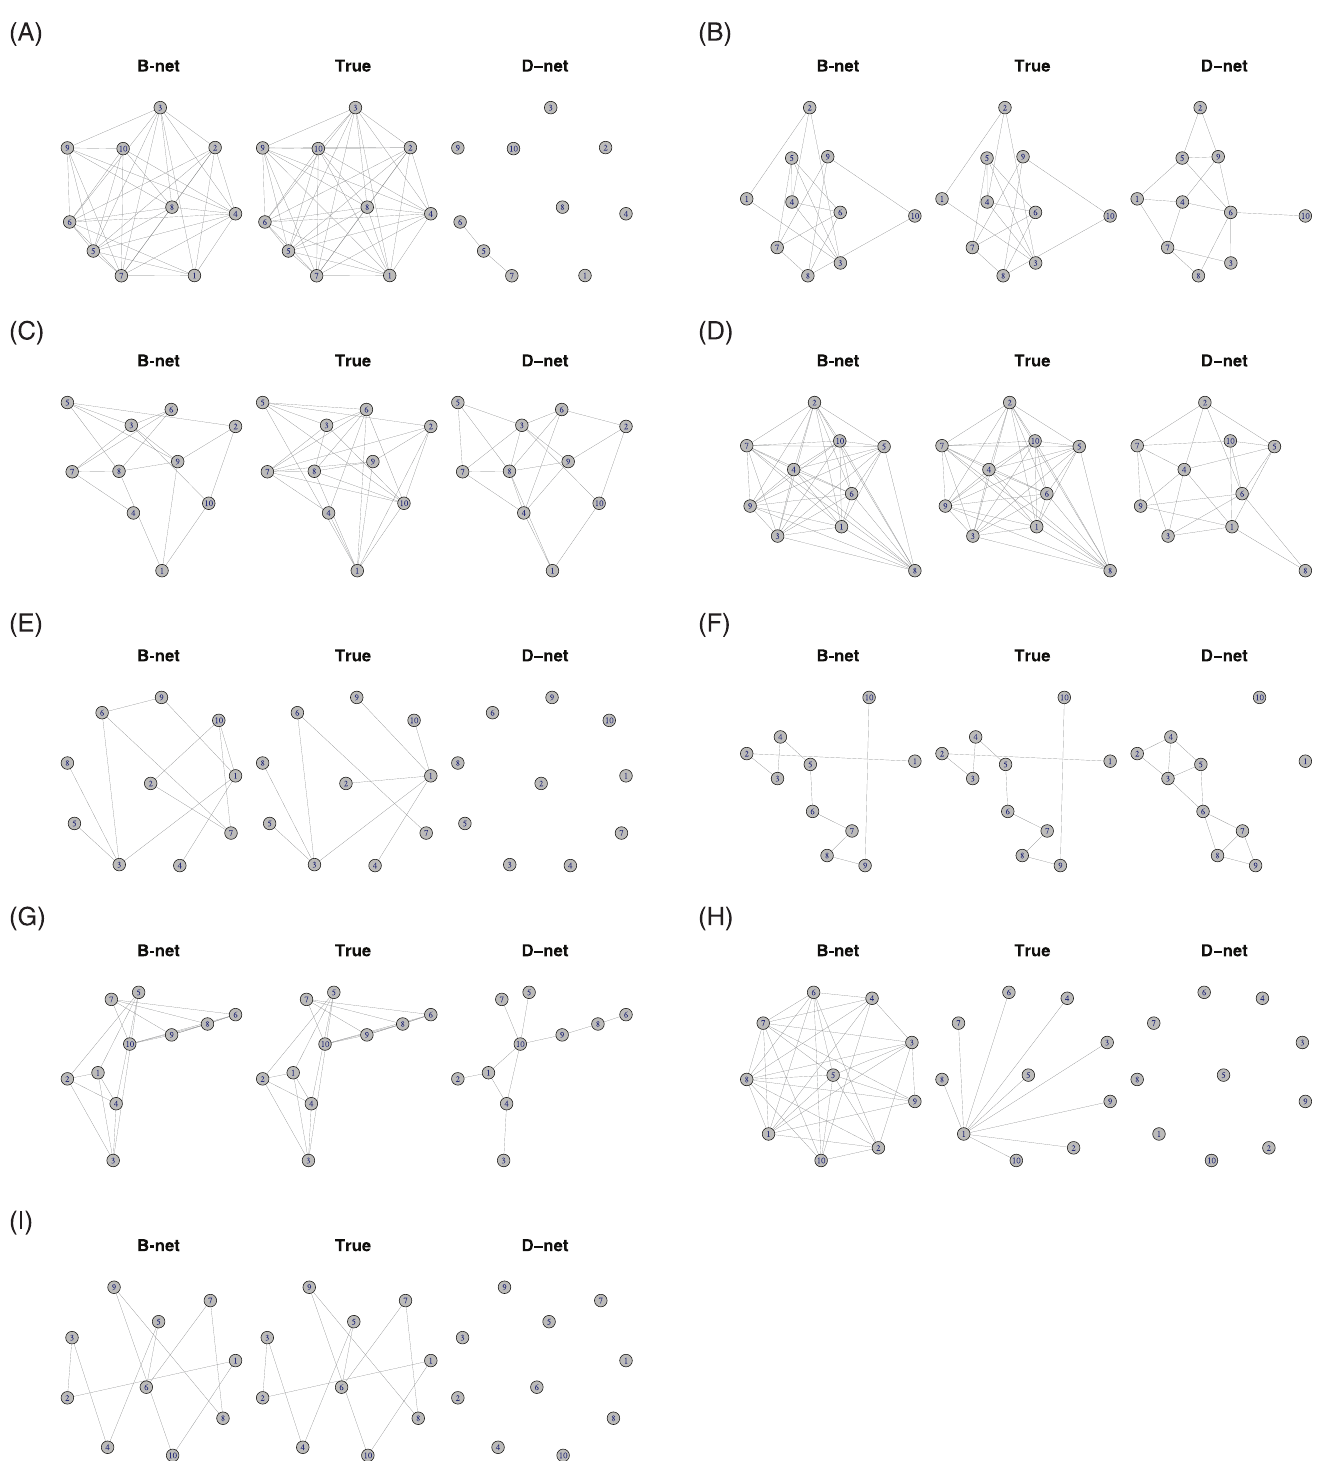
Fig 3. DN adjacency matrix graphical models. Comparison of the true DN, B-net and D-net graphical structure estimates for an AR(1), AR(2), sparse random, scale-free, band, cluster, star and circle graphical model and p = 10. (a) Model 1: AR(1). (b) Model 2: AR(2). (c) Model 3: at most 80% sparse. (d) Model 4: at most 40% sparse. (e) Model 5: scale-free. (f) Model 6: band. (g) Model 7: cluster. (h) Model 8: star. (i) Model 9: circle.